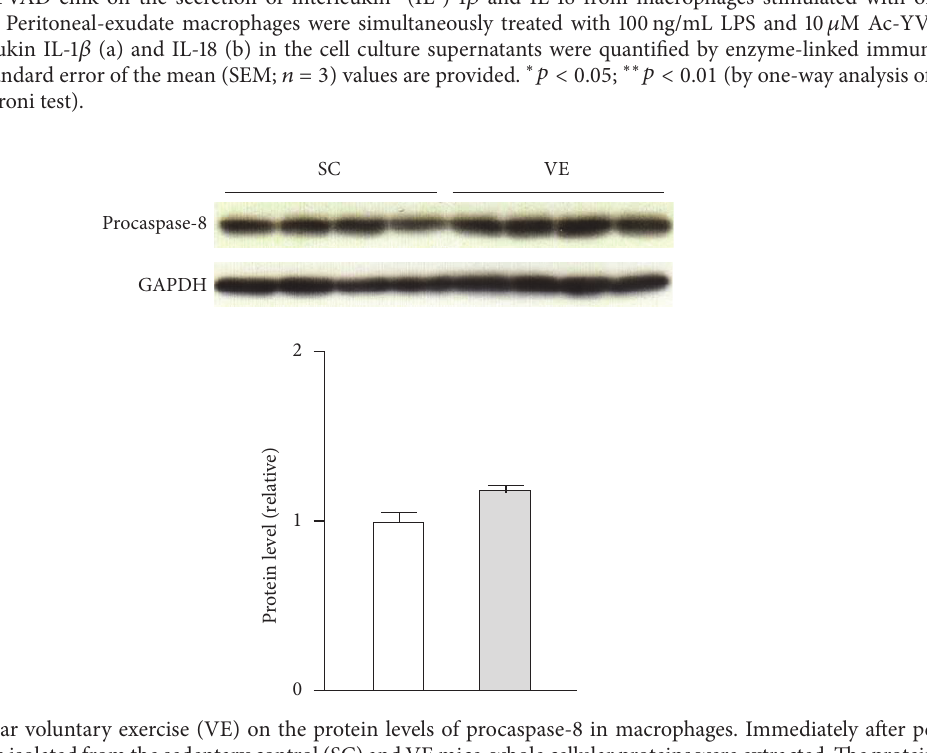
in nonobese mice. This observation is meaningful for